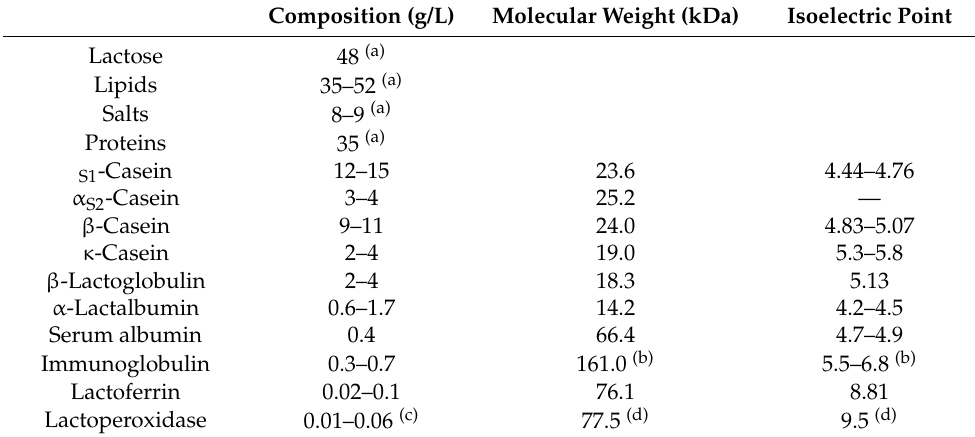
Table 1. Main components and protein profile of bovine milk [3]. Composition